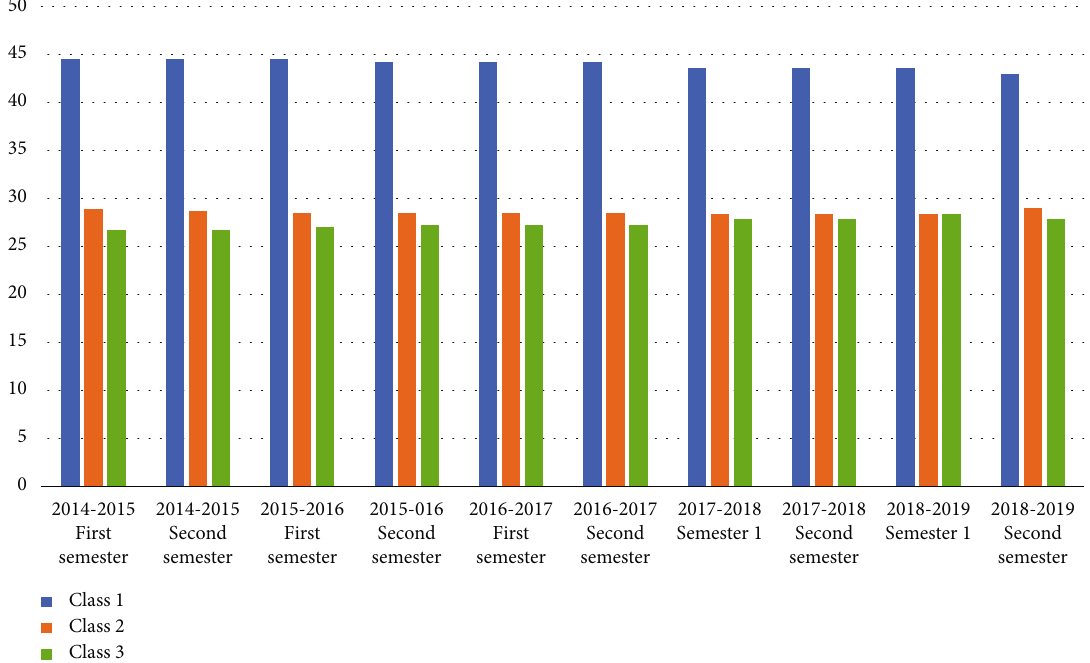
Figure 8: Histogram of the proportion of teachers in three categories in each semester of Y school in the past fi ve